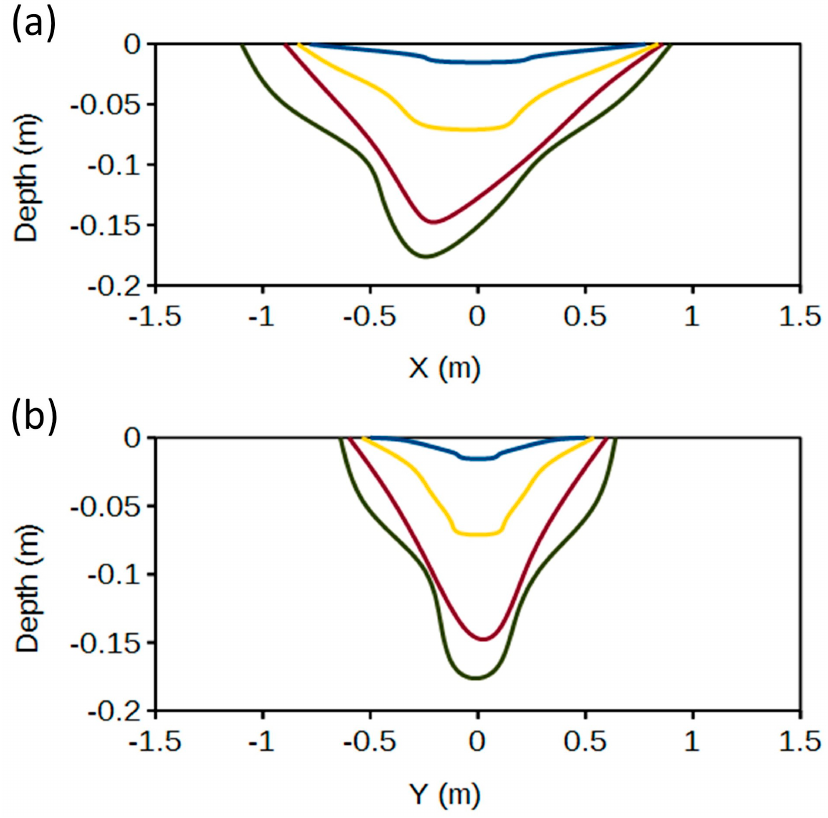
Figure 7. Contours of the hole formed by the rotating the magnetic field of the magnetized sphere in ( a ) the x -direction and ( b ) the y -direction for times 2.5 ms (blue), 10 ms (gold), 20 ms (red), and 30 ms (black). The magnetic field sweeps through plastically deformable conducting material, and the displacement of the bottom of the hole is approximately − 0.25 m in the x -direction. The same contours for the y -direction, which is along the axis of rotation, show the deformation is symmetric about y = 0, as expected. In both cases, the vertical axis has a different scale from the horizontal axis.